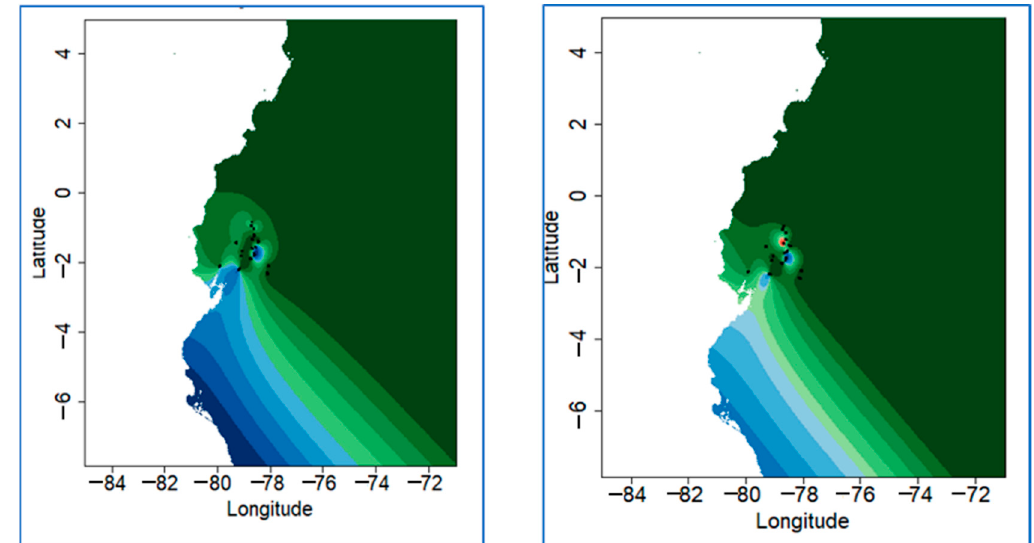
Figure 5. Plot of STRUCTURE Q matrix formed by K vectors of ancestry coefficients within a geographic map using an ascii raster file of the study area. Figure a (right), K2; and Figure b (left), K3.